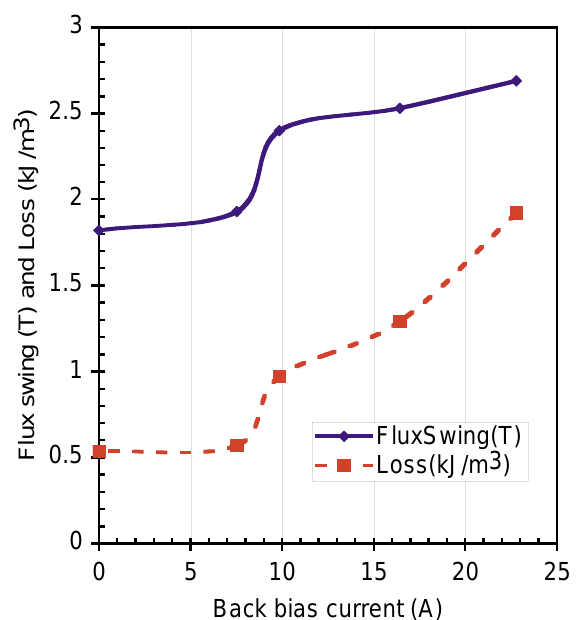
FIG. 5. (Color) Flux swing ( } , blue, solid line) and core loss ( (cid:1) , red, dashed line) both increase with backbias current for MRTI core 04-02, alloy 7421.